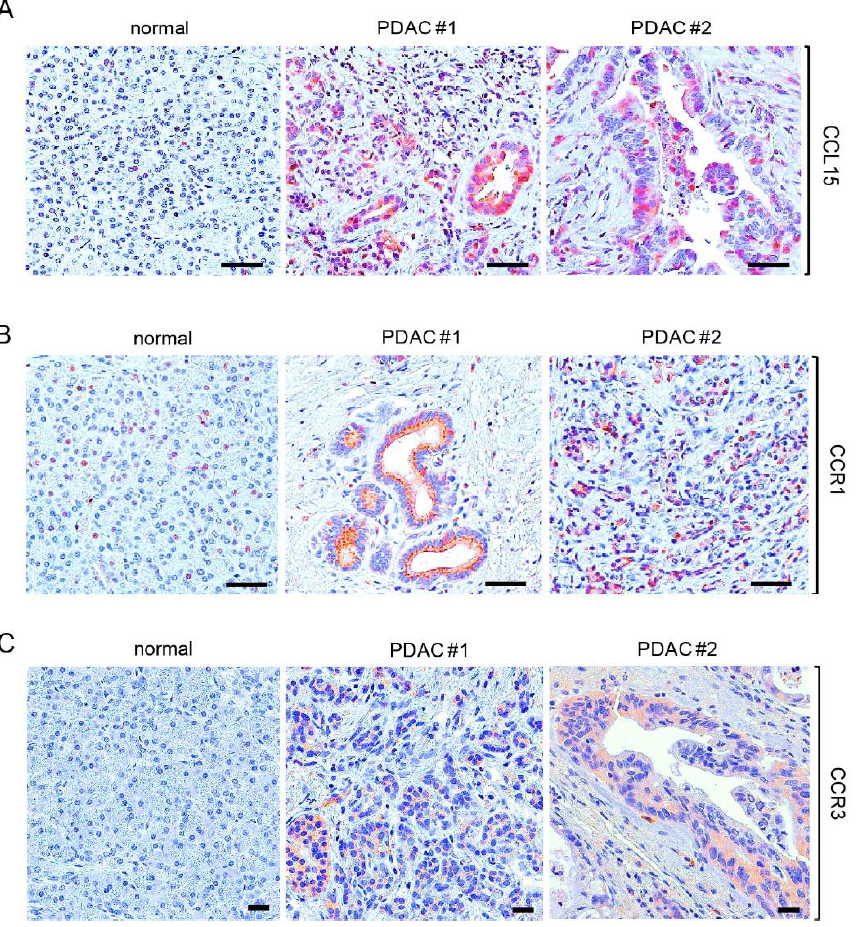
Figure 1. Increased expression of CCL15 and its receptors in human tissue samples of PDAC. ( A – C ) Human tissues of normal pancreas and PDAC were immunostained with antibodies of CCL15 ( A ), CCR1 ( B ), and CCR3 ( C ). Scale bar: 50 µm.